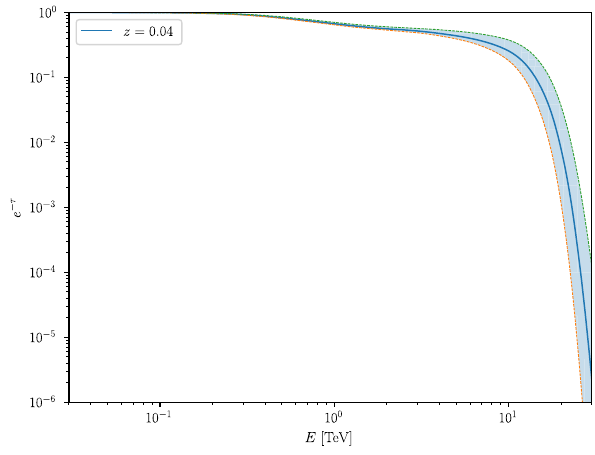
Fig. 4 The EBL attenuation ( e − τ ) of photons from a source with red- shift z = 0 . 04. The model and data are taken from Ref. [50] and http:// side.iaa.es/EBL/